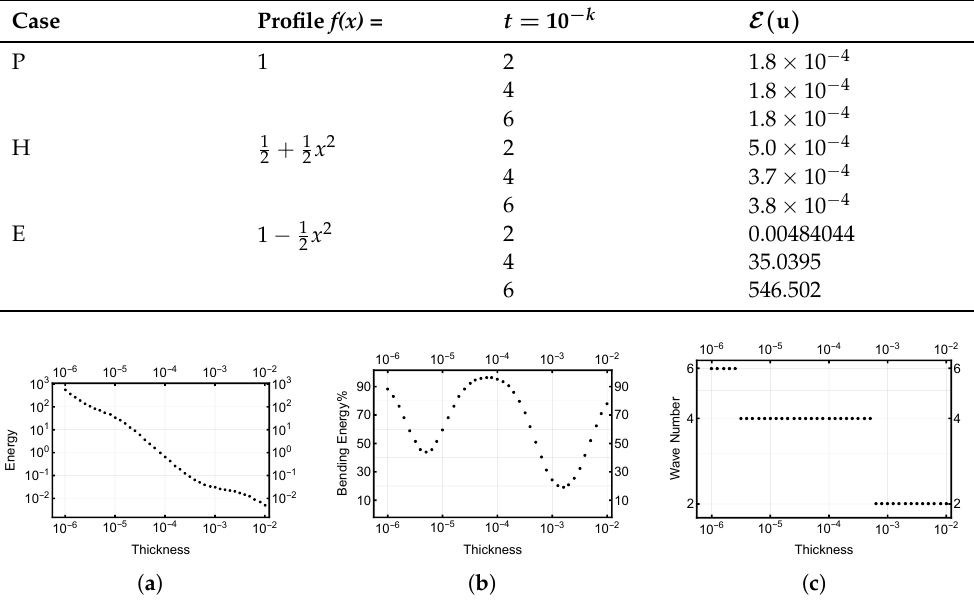
Table 1. Reference energies.